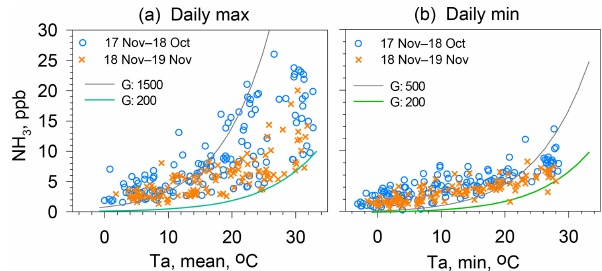
Figure 8. (a) Scatter plot showing the maximum NH 3 concentration and average air temperatures for days on which the average relative humidity is below 70% and the daily average wind speed is below 3ms − 1 . (b) Scatter plot showing daily minimum NH 3 concentra- tion and minimum air temperature for days on which the average relative humidity is below 70% and the daily average wind speed is below 3ms − 1 . Green and gray curves show compensation points for temperature using (cid:48) values shown in the